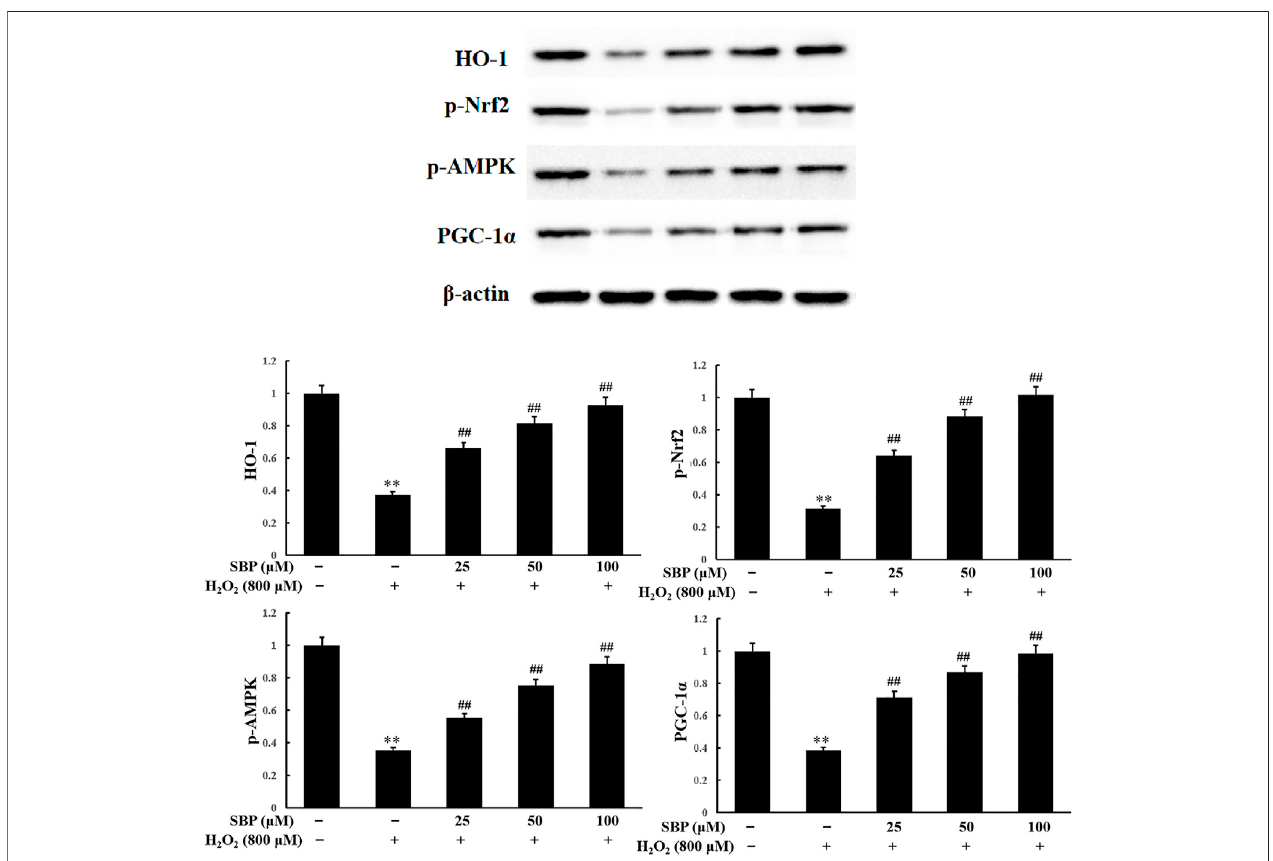
FIGURE 6| Effect of SBP on the protein expression levels ofHO-1, phosphorylated Nrf2, AMPK and PGC-1 α . After that, cell lysates were collected and subjected to western blotting analyses. Data are calculated from three independently replicated experiments. p < 0.01 compared to the control group; p < 0.01 compared to the H 2 O 2 -treated